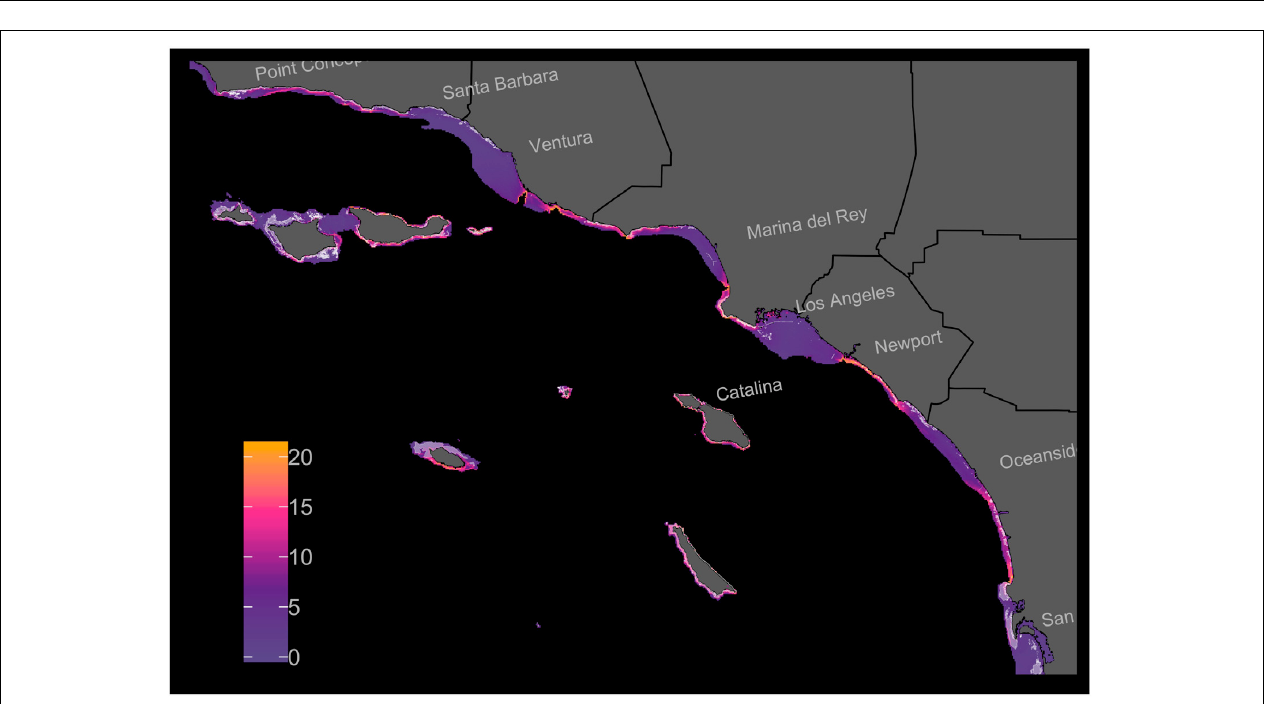
FIGURE 1 | Percent contribution of each of the six predictor variables to the individual-SDMs. Interquartile ranges shown for the three taxonomic groups, algae (red circles), fish (green triangles), and invertebrates (blue squares).